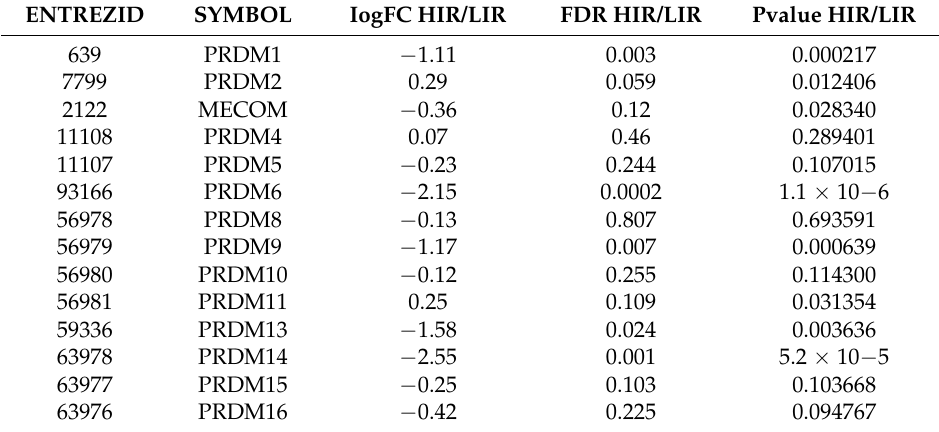
Table 1. Log-transformed fold-changes (logFC) in the expression of positive regulatory domain- containing ( PDRM) genes between low infertility risk and high infertility risk patients. ENTREZID SYMBOL IogFC HIR/LIR FDR HIR/LIR Pvalue HIR/LIR